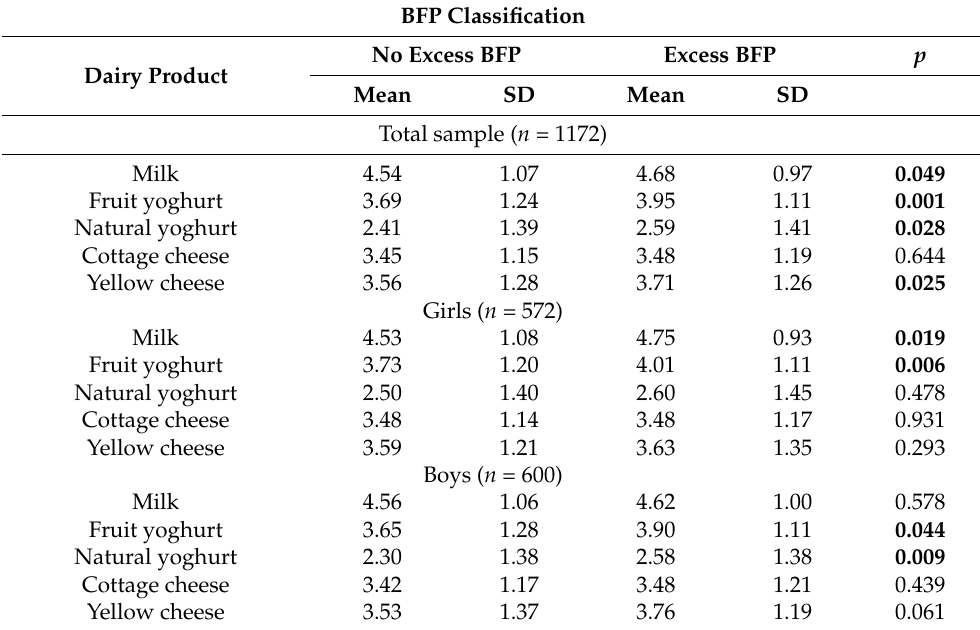
BFP—body fat percentage; significant associations are highlighted in bold.